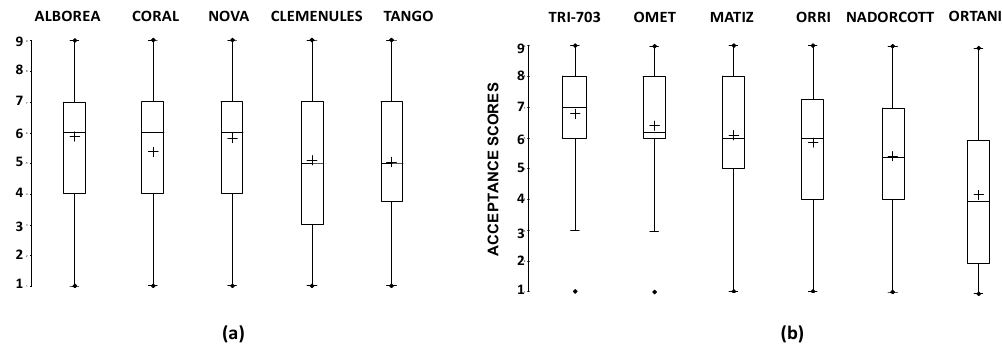
Figure 1. Box-and-wisher plots of descriptive statistics for consumers’ liking scores of the mandarin cultivars evaluated at: Harvest 1 ( a ); and Harvest 2 ( b ). The lower and upper edges of a box represent the first (Q1) and third (Q3) quartile, while the line and cross within the box show the median and the mean, respectively. The whiskers represent the lower and upper extremes of the data.